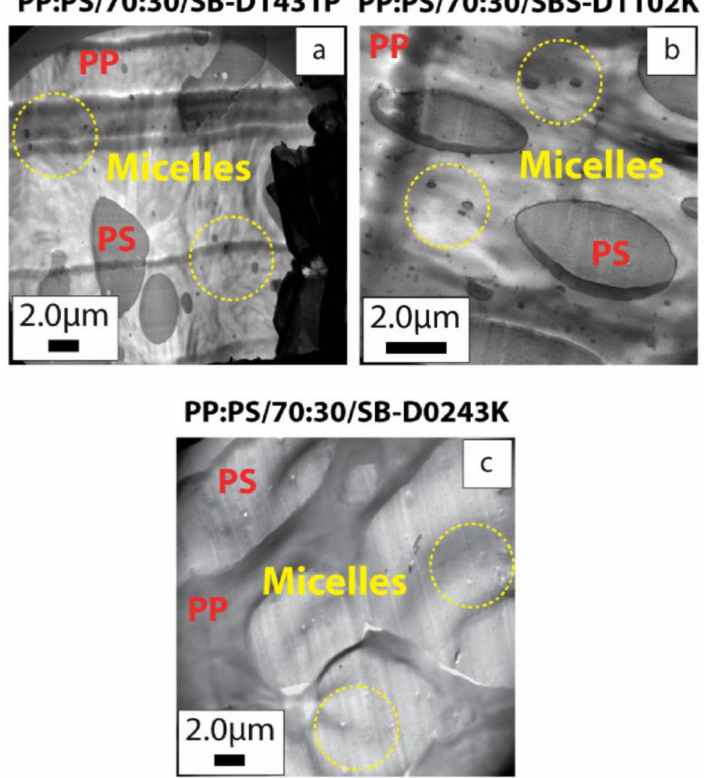
Figure 8. TEM micrographs showing micelles formation in 1.0 vol.% MWCNT and 5 vol.% copolymer filled ( a ) PP:PS/70:30/SB-D1431P, ( b ) PP:PS/70:30/SBS-D1102K, and ( c ) PP:PS/70:30/SB